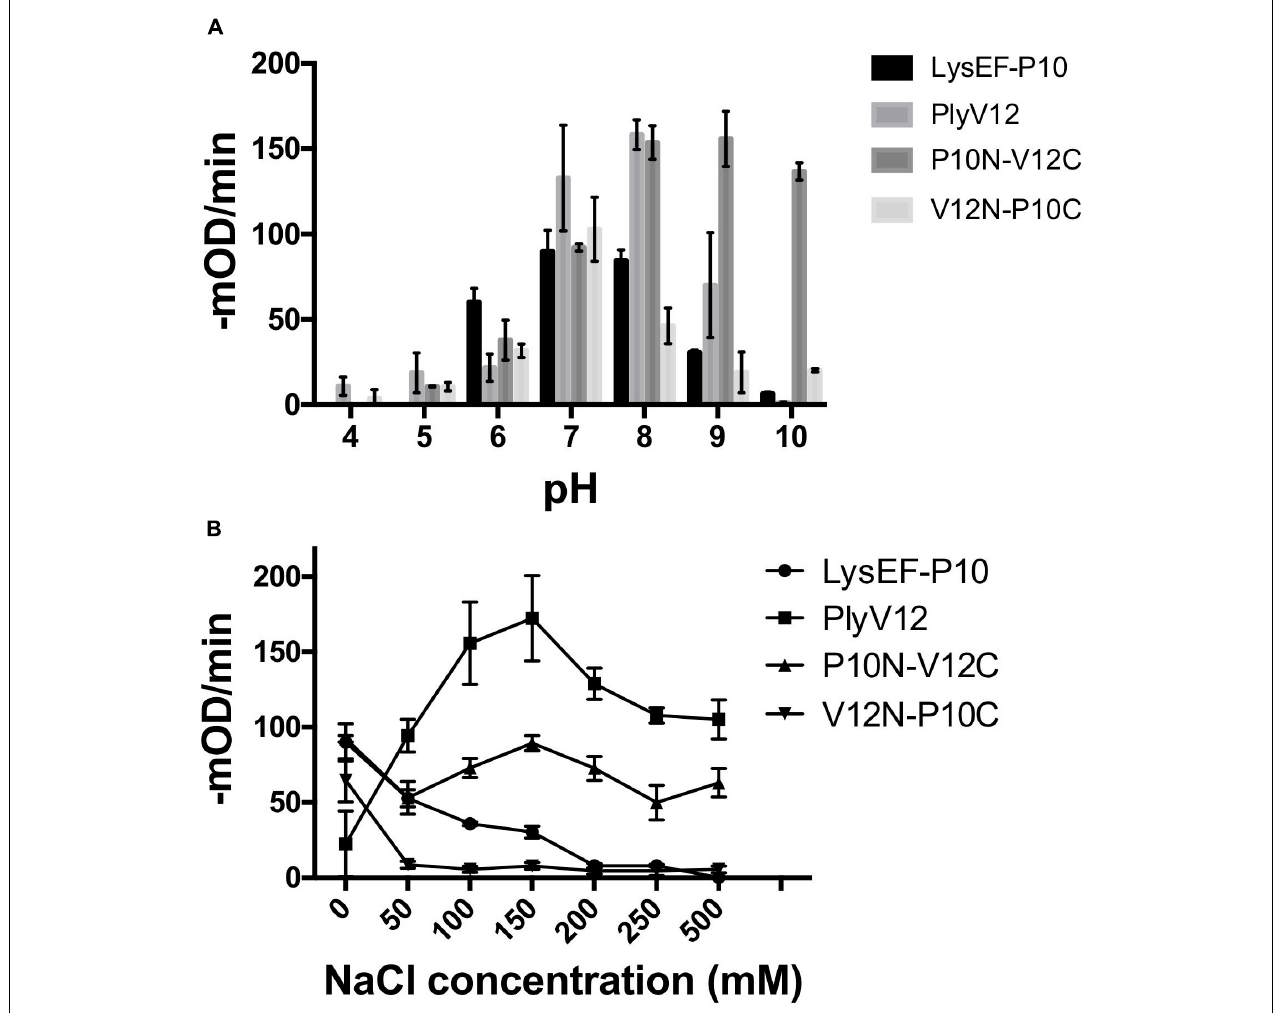
FIGURE 2 | Characterization of lysins. The lytic activities of the four lysins at various pH buffers (A) under different salt concentrations (B) . These experiments were done in biological triplicates; error bars represent standard